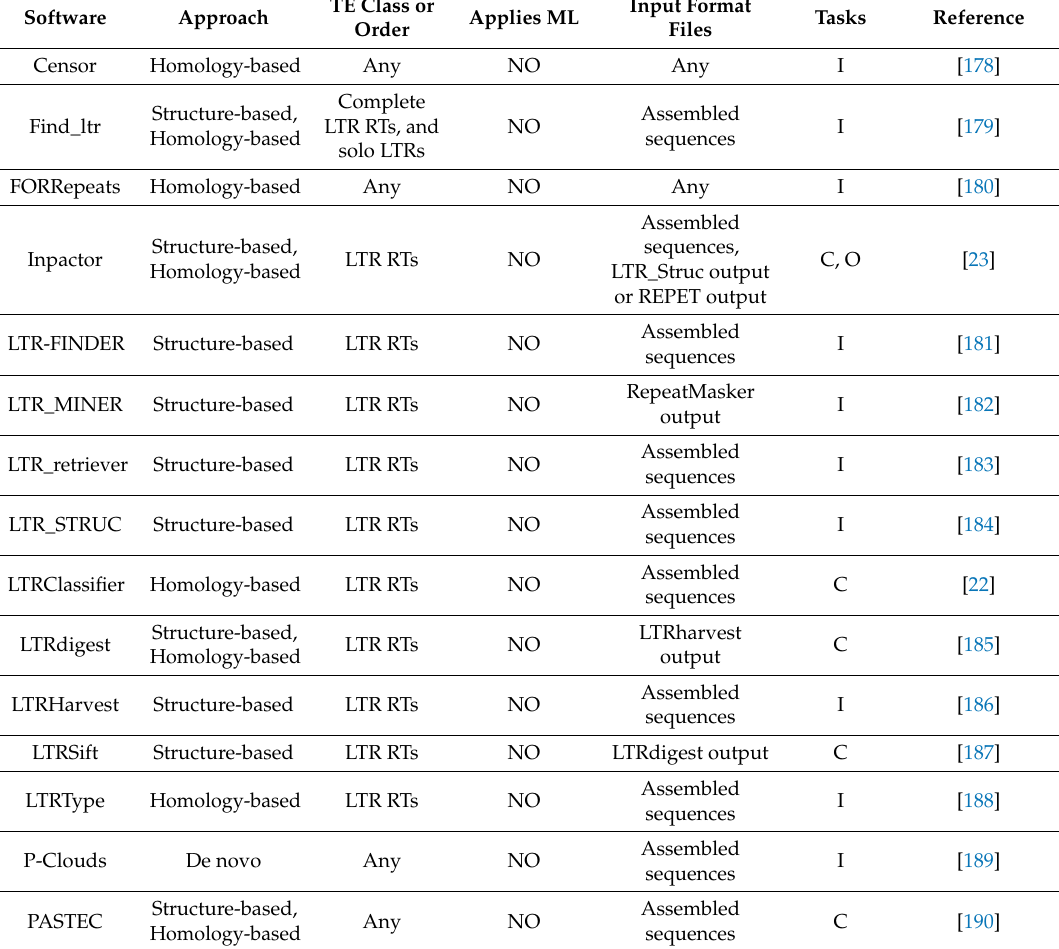
Table 4. Bioinformatics software found in the literature. I for identification, C for classification, and O for other analysis; ML for machine learning. With information from